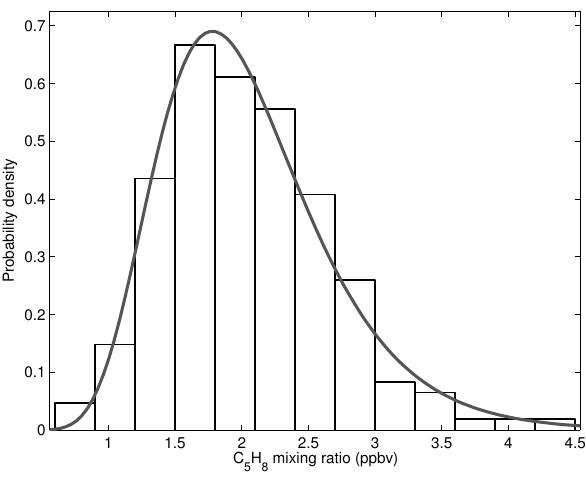
Fig. 2. Histogram showing distribution of isoprene concentrations between 11:00 and 12:00LT on 30 April 2008. The line shows the probability density function for a log-normal